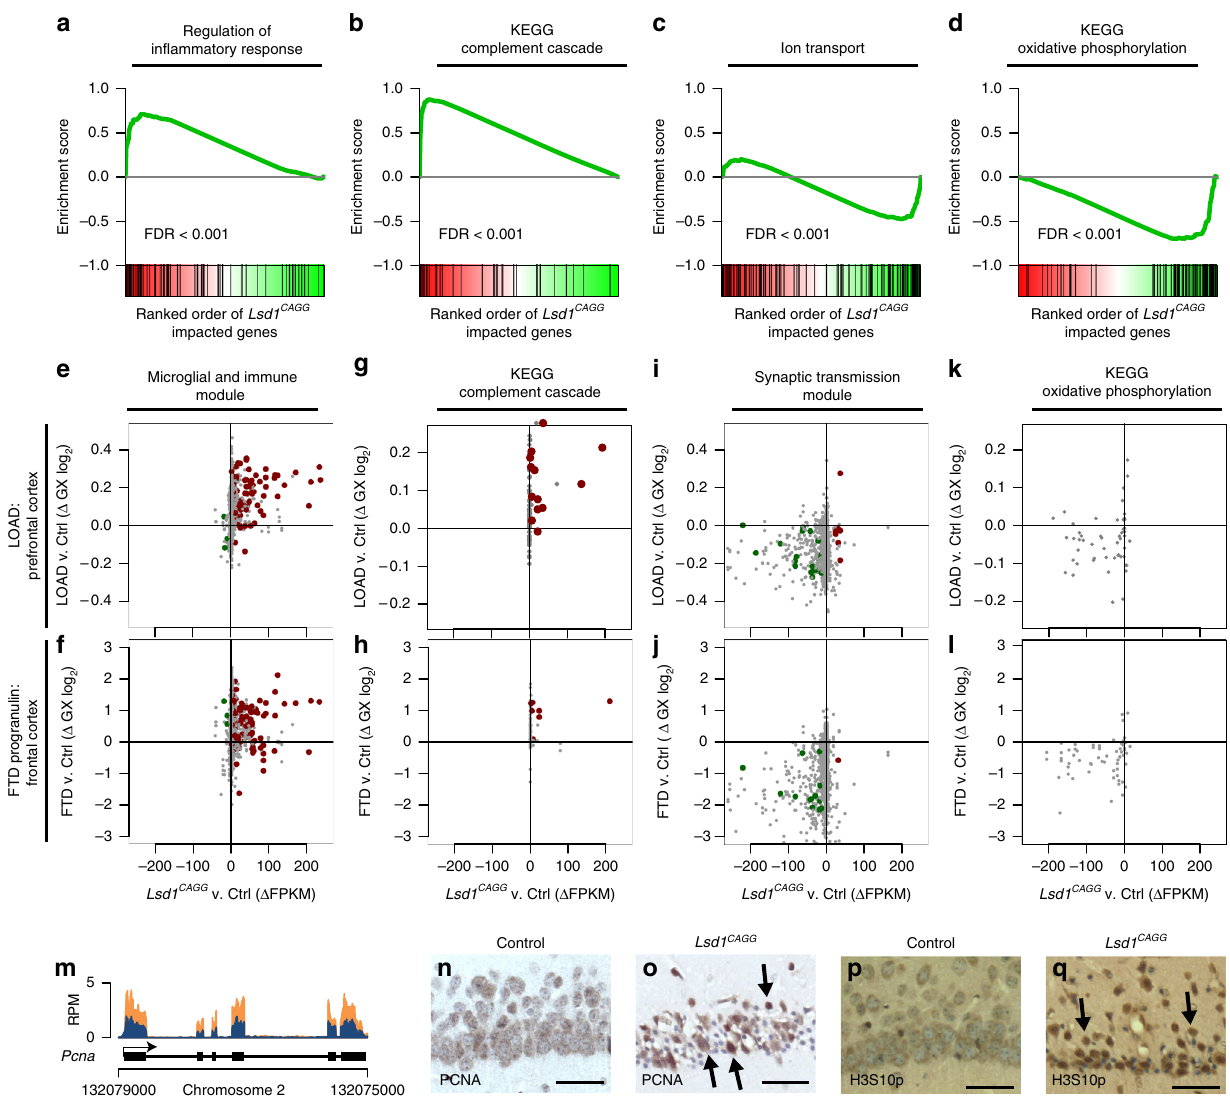
Fig. 4 Loss of LSD1 induces common neurodegeneration pathways. a – d Gene set enrichment plots of neurodegeneration pathways where Lsd1 CAGG impacted transcripts ( x -axis) are sorted by magnitude of upregulation (red) to downregulation (green). The position of each gene from the gene set is represented as a black tick mark ( x -axis). Enrichment score ( y -axis) shows where enrichment of genes from the set occurs in the Lsd1 CAGG transcriptome. Gene sets shown are regulation of in fl ammatory response a , Kyoto Encyclopedia of Genes and Genomes (KEGG) complement cascade b , ion transport c , and KEGG oxidative phosphorylation d . FDR is shown for each plot. e – l Scatter plots showing correlated changes in gene expression of genes from the Microglial and Immune Module 36 e , f , KEGG complement cascade g , h , Synaptic Transmission Module 36 i , j and KEGG oxidative phosphorylation k , l gene sets between the Lsd1 CAGG and control hippocampus (FPKM, x -axes) compared with the changes in log 2 gene expression between late onset AD (LOAD) and control prefrontal cortex 36 ( e , g , i , k ; y -axis), or compared with the changes between FTD-progranulin and control frontal cortex 37 ( f , h , j , l ; y -axis). The most signi fi cantly changed genes in the Lsd1 CAGG hippocampus (Supplementary Fig. 11d, e) are shown in red (upregulated) and green (downregulated). All other genes with a direct mouse/human orthologue are shown in gray. Genes with correlated expression changes are found in the top right and bottom left quadrants, while genes that do not correlate are found in the other quadrants. m Genome browser style plot (as described in Fig. 3a – d) showing Pcna expression in Lsd1 CAGG hippocampus (orange) compared with control (blue). n – q Immunohistochemistry with antibodies to PCNA n , o , and H3S10p p , q in control n , p and Lsd1 CAGG o , q CA1 neuronal nuclei. Arrows denote non-pyknotic nuclei. All IHC is counterstained with hematoxylin. All Lsd1 CAGG images are taken at the terminal phenotype. Scale bar = 50 µ